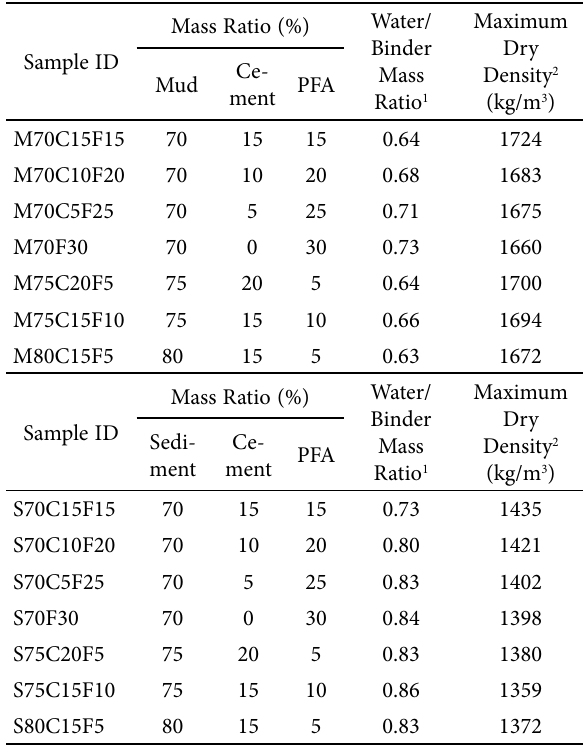
Table 3. Mix proportions of S/S treated marine mud and